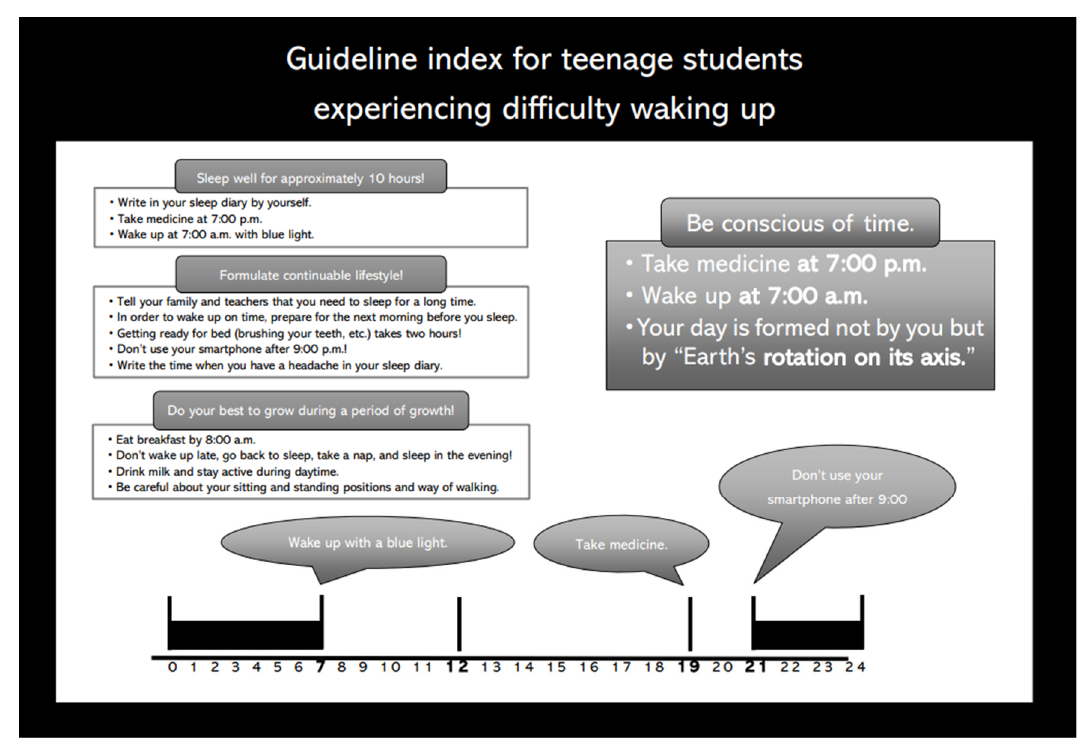
Figure 1. Booklet on sleep hygiene guidance (a sample: 10 h sleeper specifications).